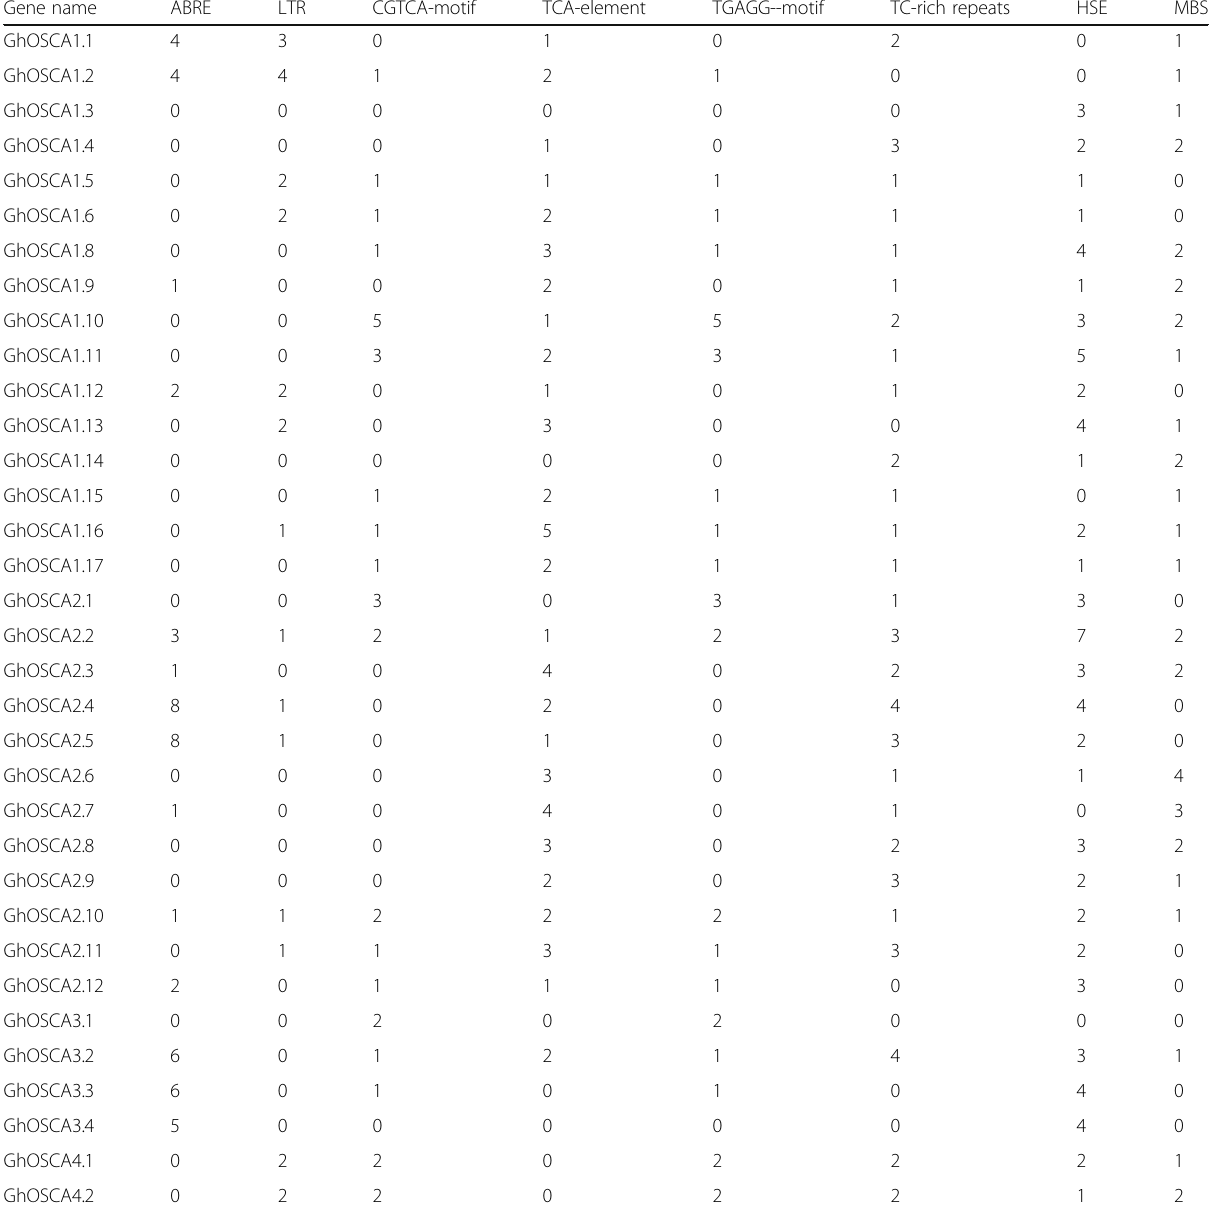
Table 4 The cis -regulatory element analysis of GhOSCA